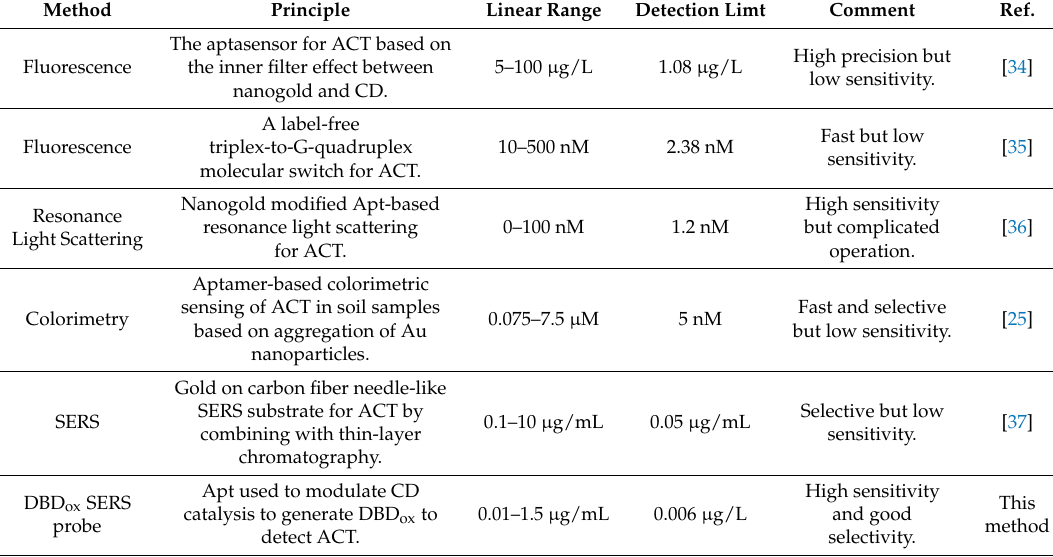
Table 5. Determination results of ACT in water samples.